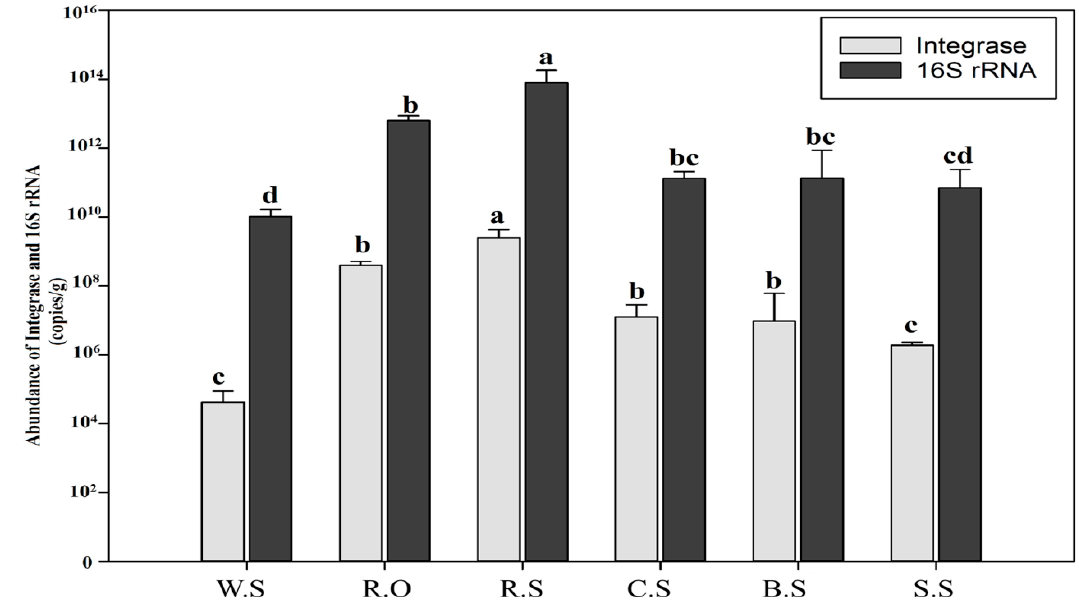
Figure 1. Concentration/copy number of the CL1 integron integrase gene and the 16S rRNA gene in each sample. The off-white bar indicates the concentration/copy number per gram of soil of the integrase gene in each soil sample, while the black bar indicates the 16Sr RNA copy number per gram of soil in each sample. Differences in the copy numbers of each sample group were evaluated using the Least Significant Difference (LSD). Different letters (a, b, c, d) above the column indicate